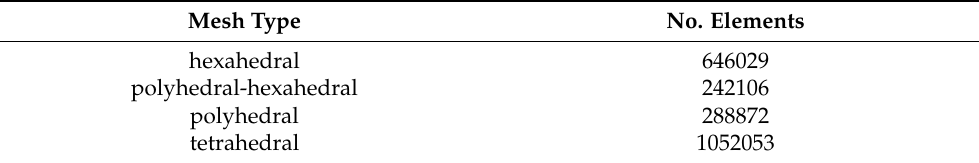
Table 1. Number of elements for different mesh